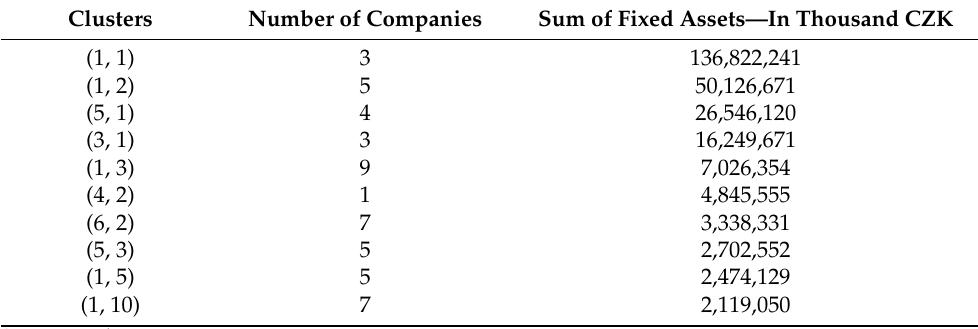
Table 16. Table of ten clusters with the highest total sum of fixed assets for the year 2018. Clusters Number of Companies Sum of Fixed Assets—In Thousand CZK 136,822,241